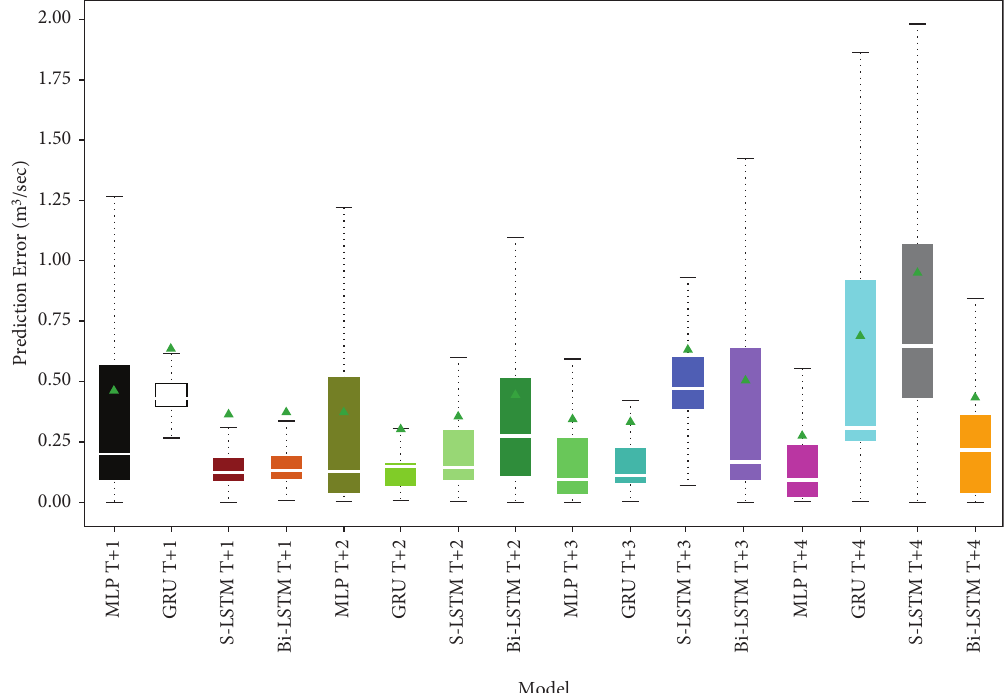
Figure 10: Spread of prediction error (m 3 /s) or box plot for the proposed models during the test period (Borkena station). 0.02.55.07.510.012.515.017.5